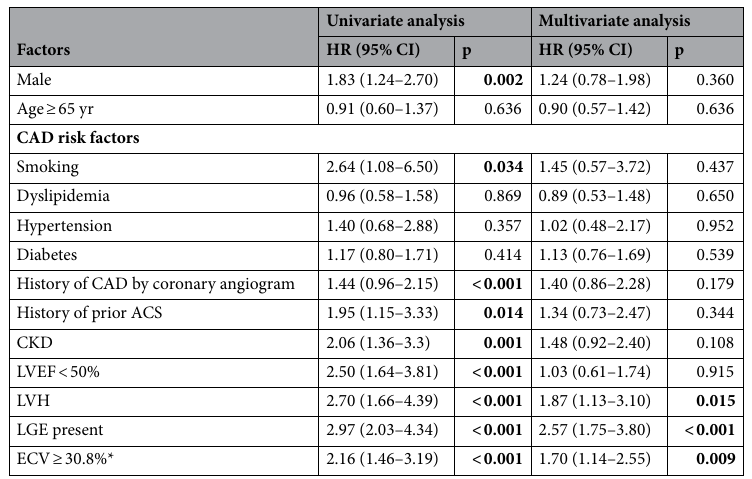
Table 2. Univariate and multivariate analyses for factors predicting the composite cardiovascular outcomes. A p -value < 0.05 indicates statistical significance (bold). HR, hazard ratio; CI, confidence interval; CAD, coronary artery disease; ACS, acute coronary syndrome; CKD, chronic kidney disease; LVEF, left ventricular ejection fraction; LVH, left ventricular hypertrophy; LGE, late gadolinium enhancement; ECV, extracellular volume. *Top